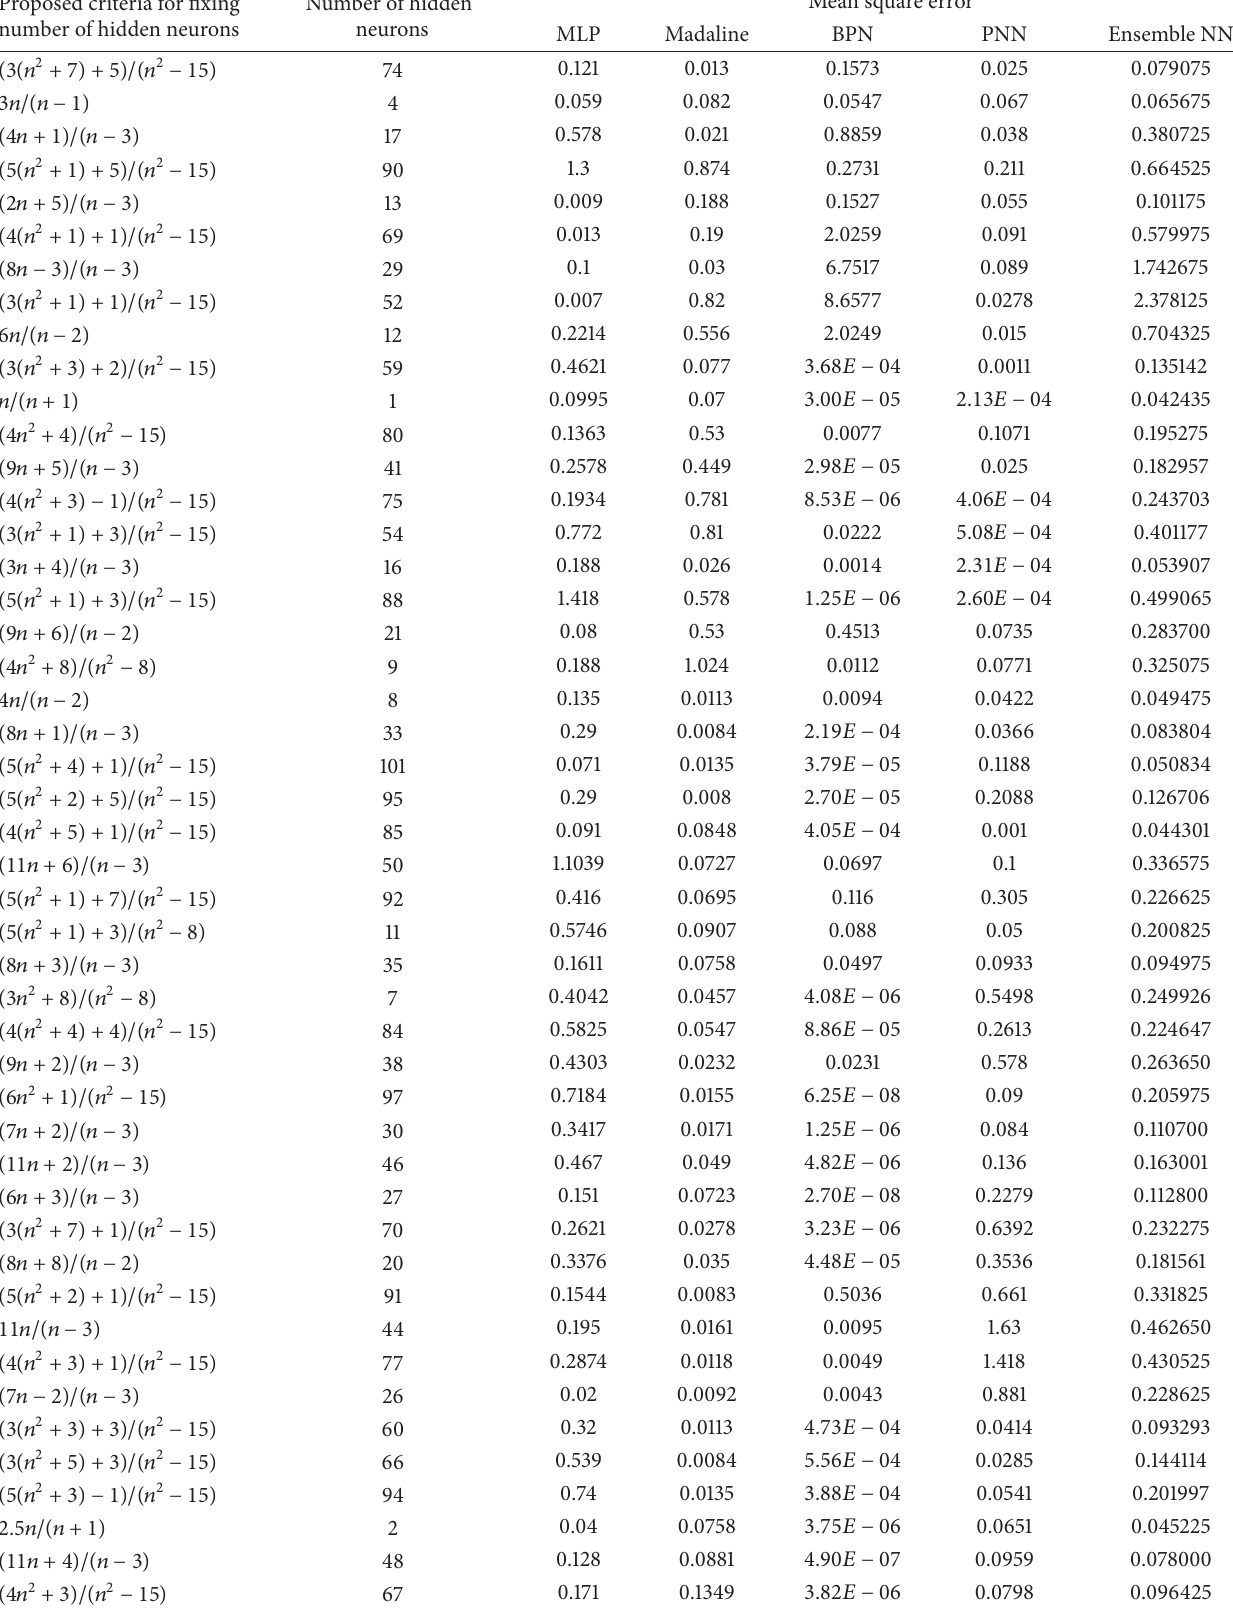
Table 5: Proposed criteria with computed mean square error for fixing the hidden neurons in ensemble neural network model. Proposed criteria for fixing Number of number of hidden neurons